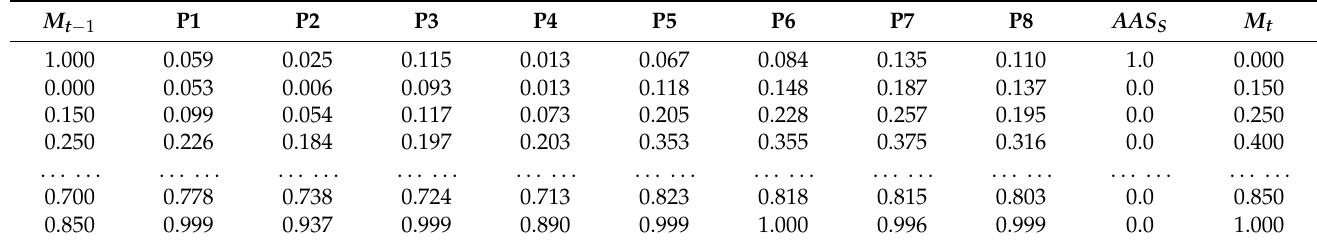
Table 2. Some of the data after convenience perception model preprocessing.